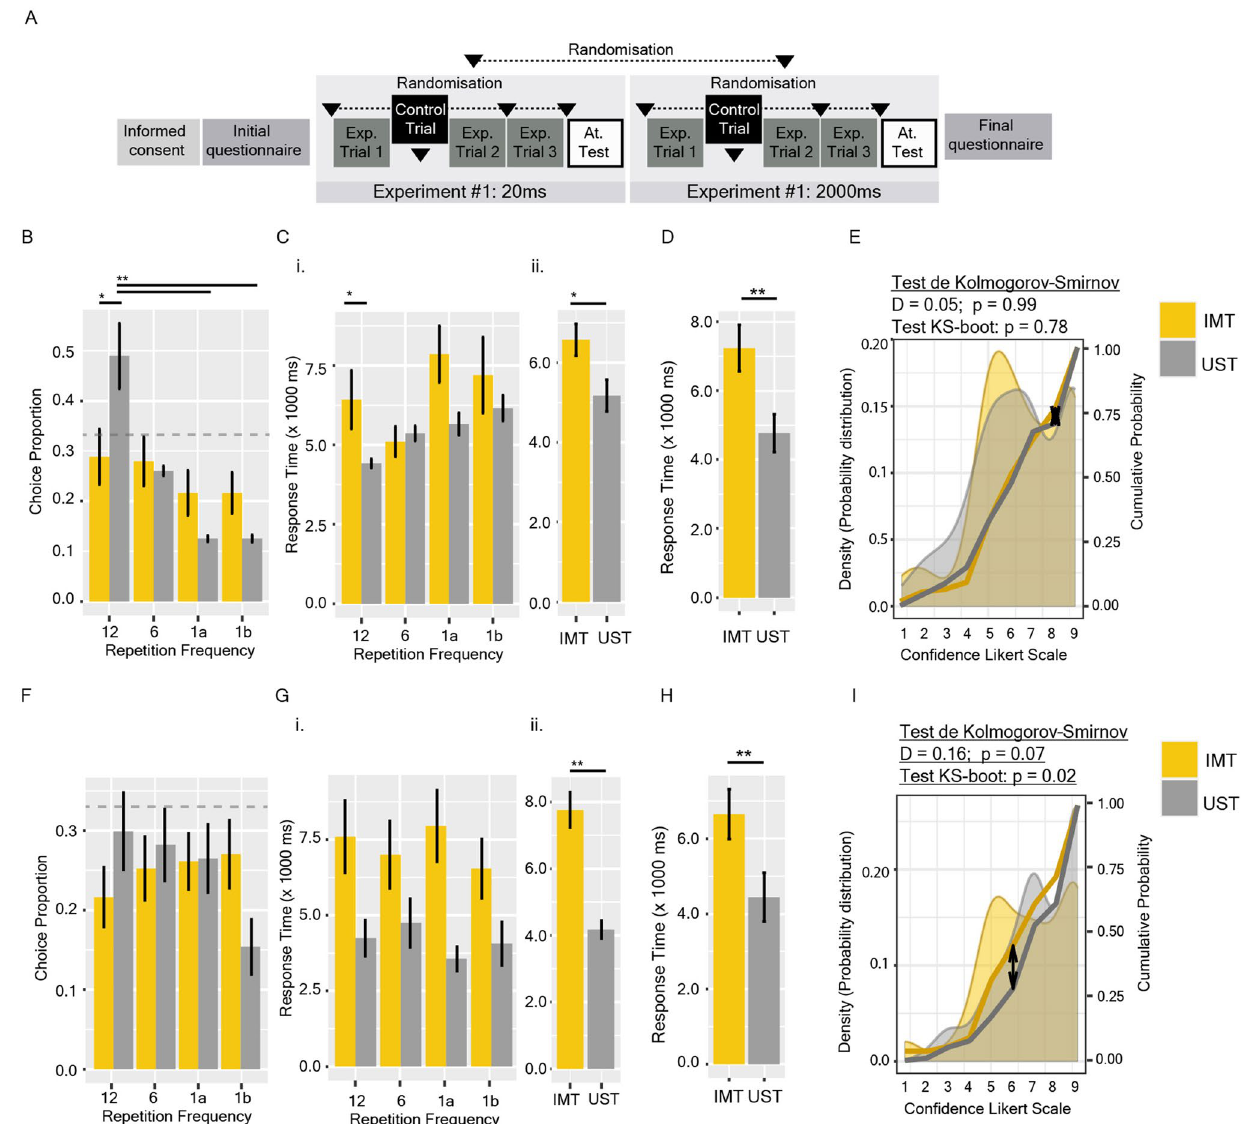
Figure 2. Parametric conditions under which repetition priming induces choice preference. ( A ) Experimental Series #2 design. The order in which both versions of Experiment #1 [Subliminal condition: 20 ms face presentation; Lasting condition: 2000 ms] appear, as well as Control Trial position, were all randomised for each participant. ( B – E ) Subliminal condition: ( B ) Choice Preference as the proportion of the chosen face over a total of 3 trials. ( C ) Response Time separated by the chosen face frequency (i) or by group (ii). ( D ) Response Time, desegregated by group, of Control trials. ( E ) Probability Distribution of reported confidence. ( F – I ) Lasting condition: ( F ) Choice Preference as the proportion of the chosen face over a total of 3 trials. ( G ) Response Time separated by the chosen face frequency (i) or by group (ii). ( H ) Response Time, desegregated by group, of Control trials. ( I ) Probability Distribution of reported confidence. Areas show the density probability distribution; yellow and grey lines show the cumulative probability. Differences in the cumulative probabilities were analysed by the Kolmogorov–Smirnov (KS) Test: the arrow revealed the highest distance between distributions. Significances were also analysed by bootstrapping. Bars shown mean ± SEM. The grey dashed line represents the expected proportion for random choice (null hypothesis). *p < 0.05, **p <